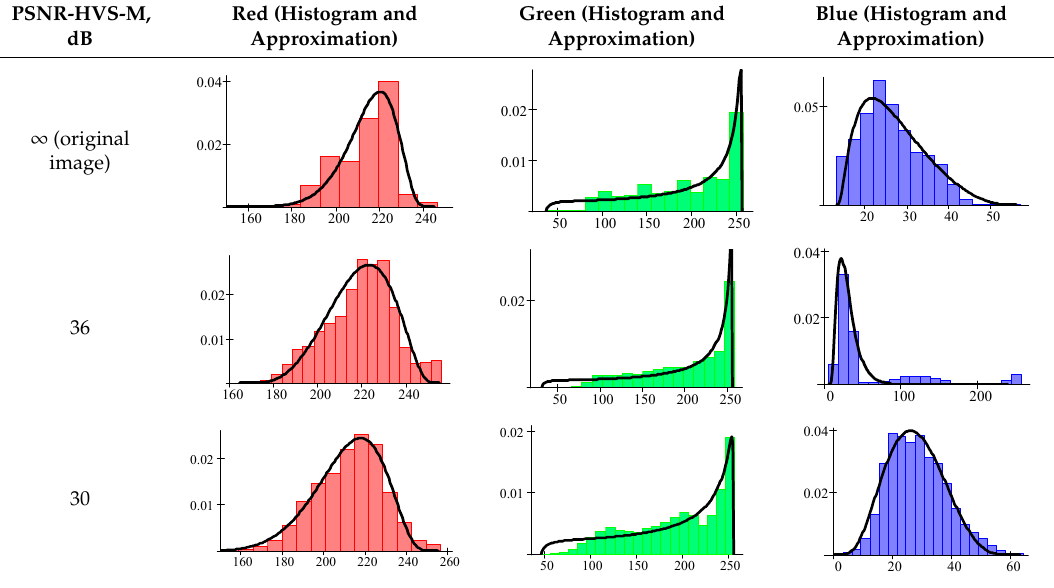
Table 4. Illustration of distribution changes due to lossy compression for Class 2.